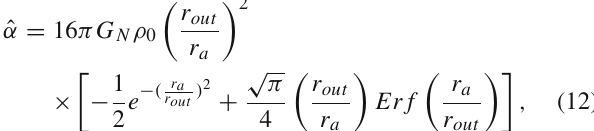
Fig. 4 f ( R ) deflection angle profile obtained for δ ≈ 10 − 6 with the r 0 = 10 2 . 215 kpc for the galaxy NGC 4138. The deflection angle increases withmass concentrationand decreases inthe dynamical f ( R ) background geometry. The value of closest approach is approximately 6 kpc